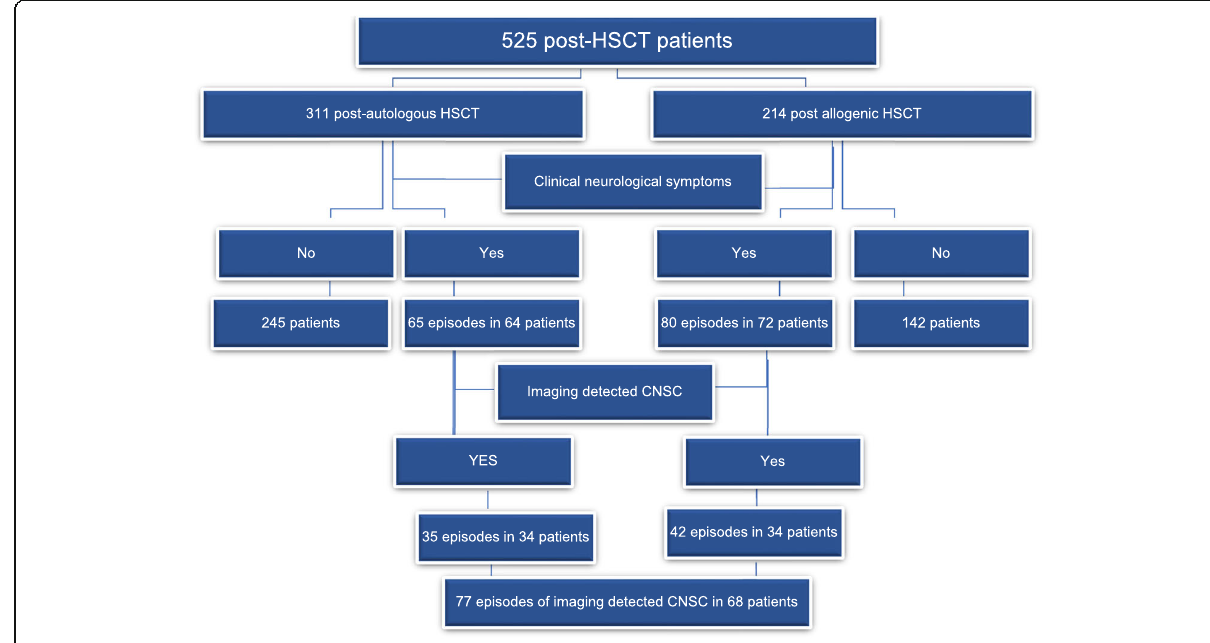
Fig. 1 Categorization of the HSCT patients included in the